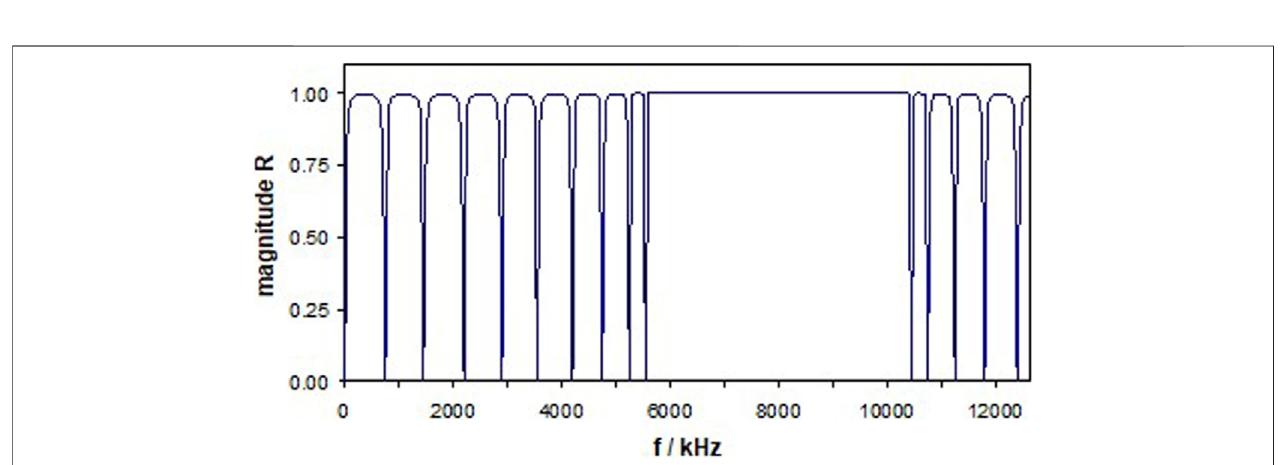
FIGURE 3 | Frequency dependence of the magnitude of the re fl ection coef fi cient, R , of a regular one-dimensional phononic crystal (1D-PnC). The PnC consists of 19 layers of Fe (steel) and 18 layers of Al and faces semi-in fi nite layers of H 2 O.